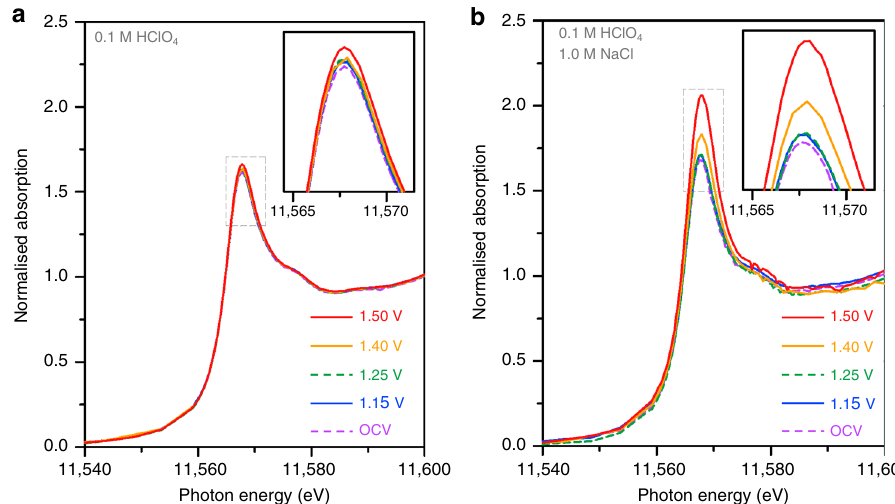
Fig. 3 In situ electrochemical Pt L 3 -edge XANES spectra of Pt 1 /CNT catalyst in the absence and presence of NaCl. XANES spectra a in the absence and b in the presence of 0.1 M NaCl taken under sequentially applied potentials without electrode rotation. The insets show a magni fi ed view of the white line regions.